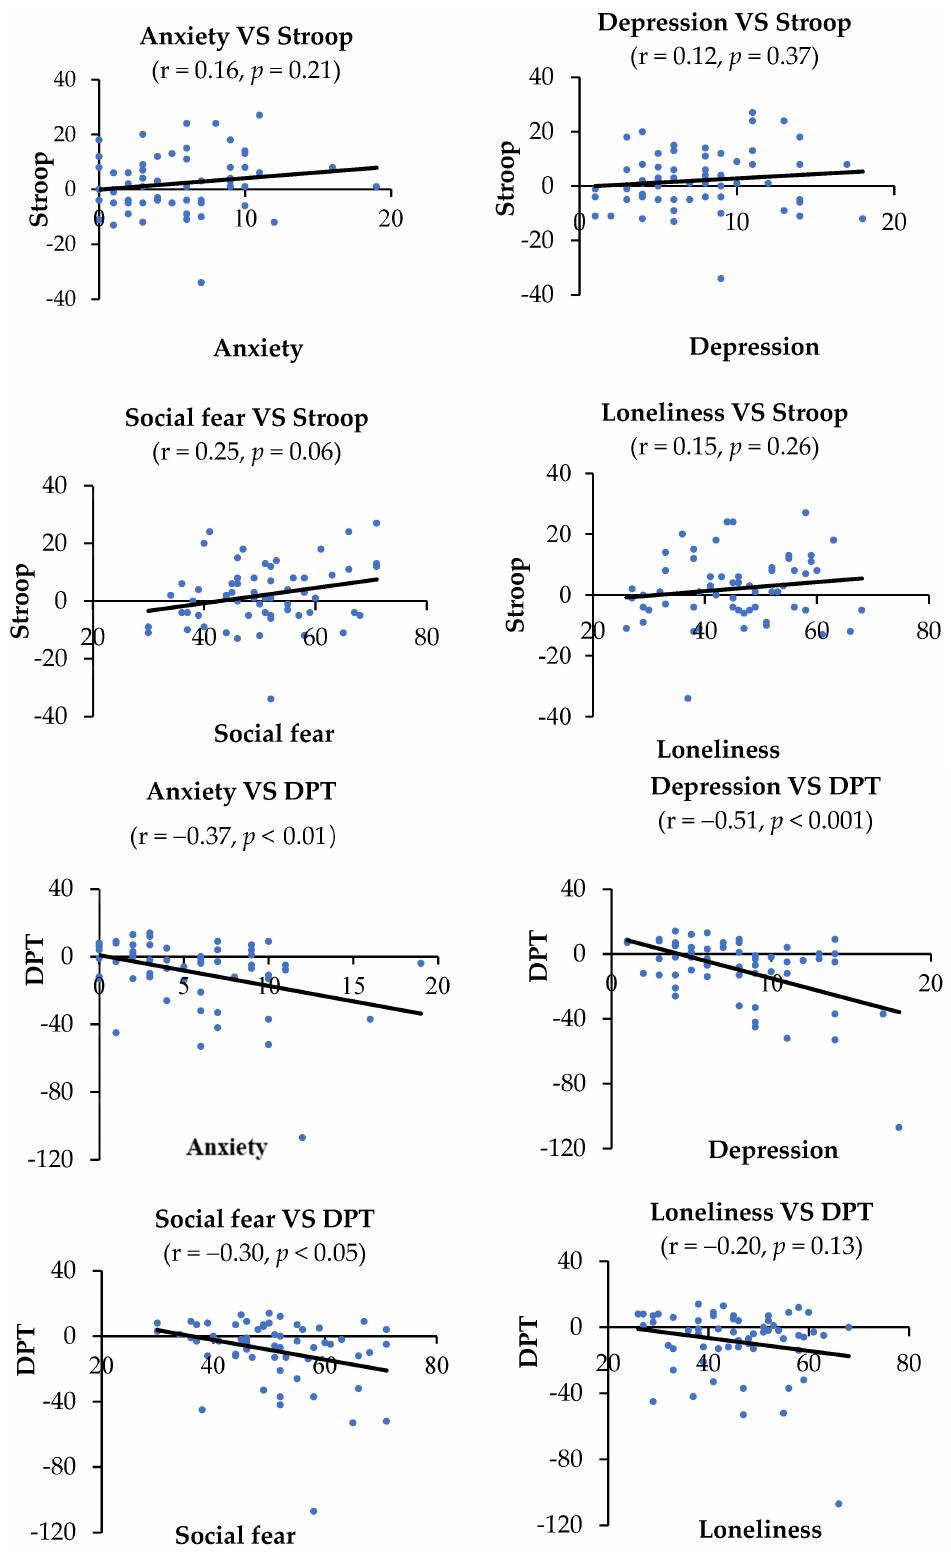
Figure 5. Correlations between negative emotions and the index of AB in the addiction Stroop and DPT. The index of AB was negatively correlated with anxiety (r = − 0.37, p < 0.01), depression (r = − 0.51, p < 0.001), and social fear (r = − 0.30, p < 0.05) in the